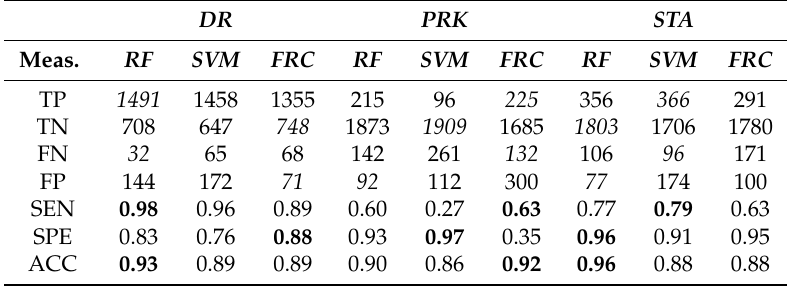
Table 8. Sensitivity (SEN), specificity (SPE) and accuracy (ACC) of the candidates for the fine-grained classifier along with their number of true positives (TP), false positives (FP), true negatives (TN) and false negatives (FN). DR